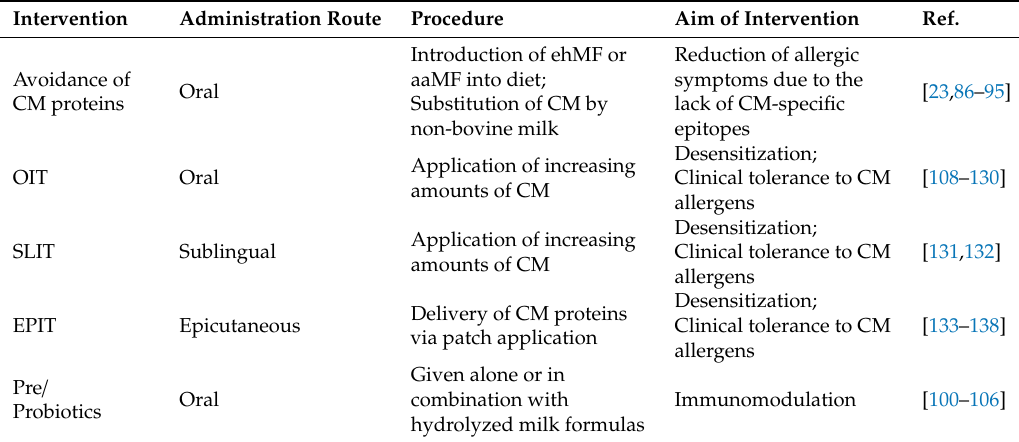
Table 2. Current strategies for the treatment of cow’s milk